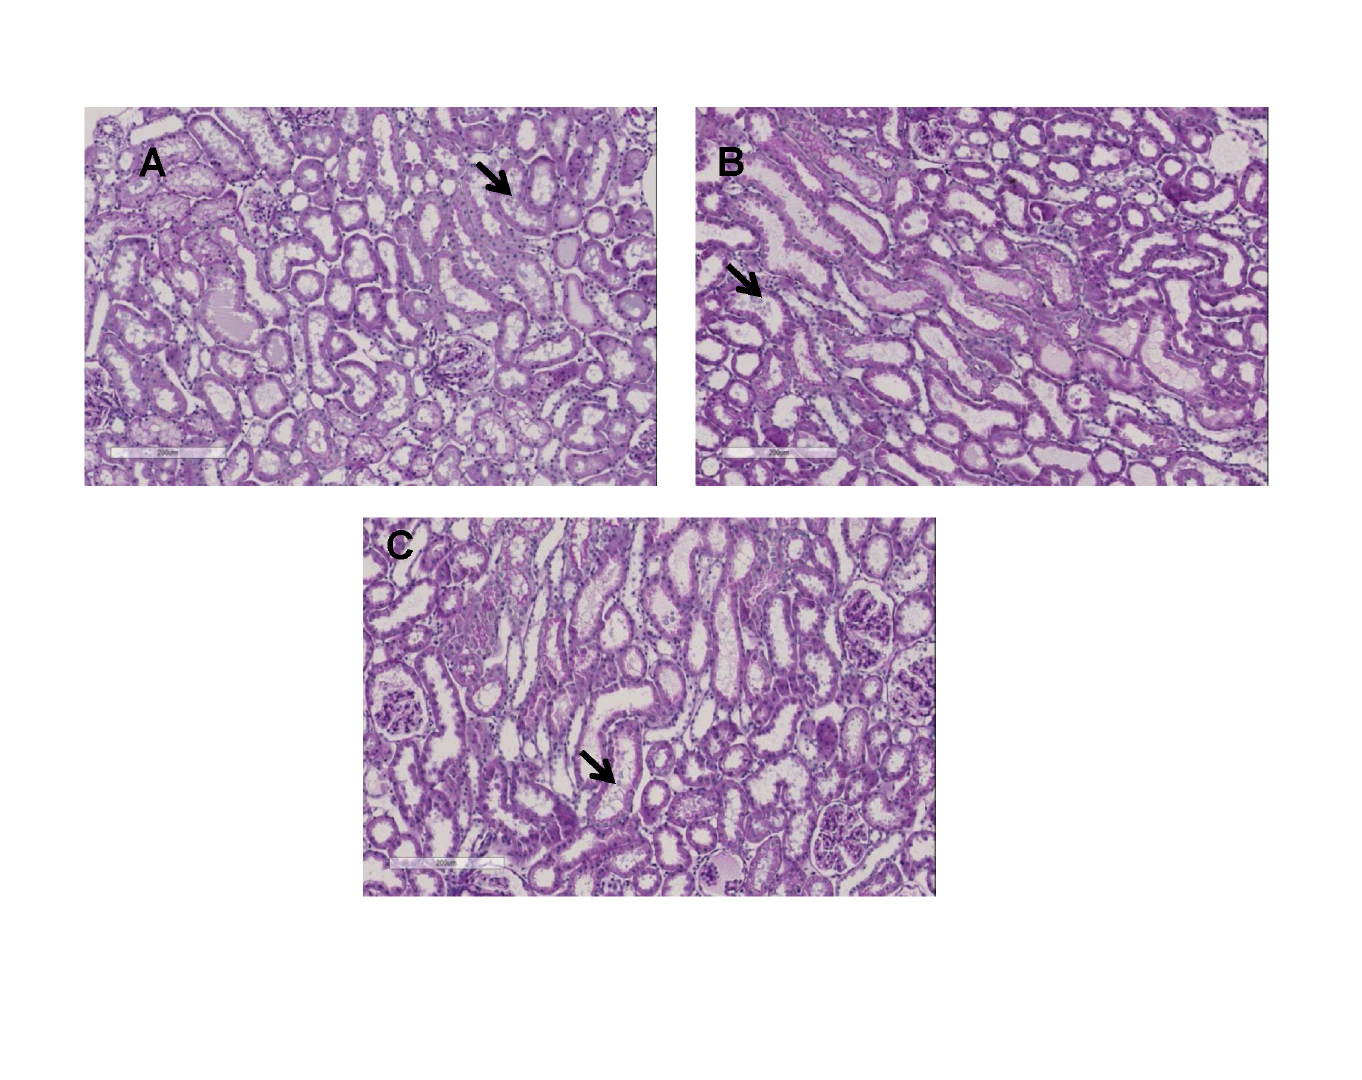
Fig 4. Examples of H&E staining of kidney tissue subjected to: Panel A, immediate rewarming (control group) or gradual rewarming at 10°C Panel B, 25°C Panel C. Epithelial shredding is pointed in all the